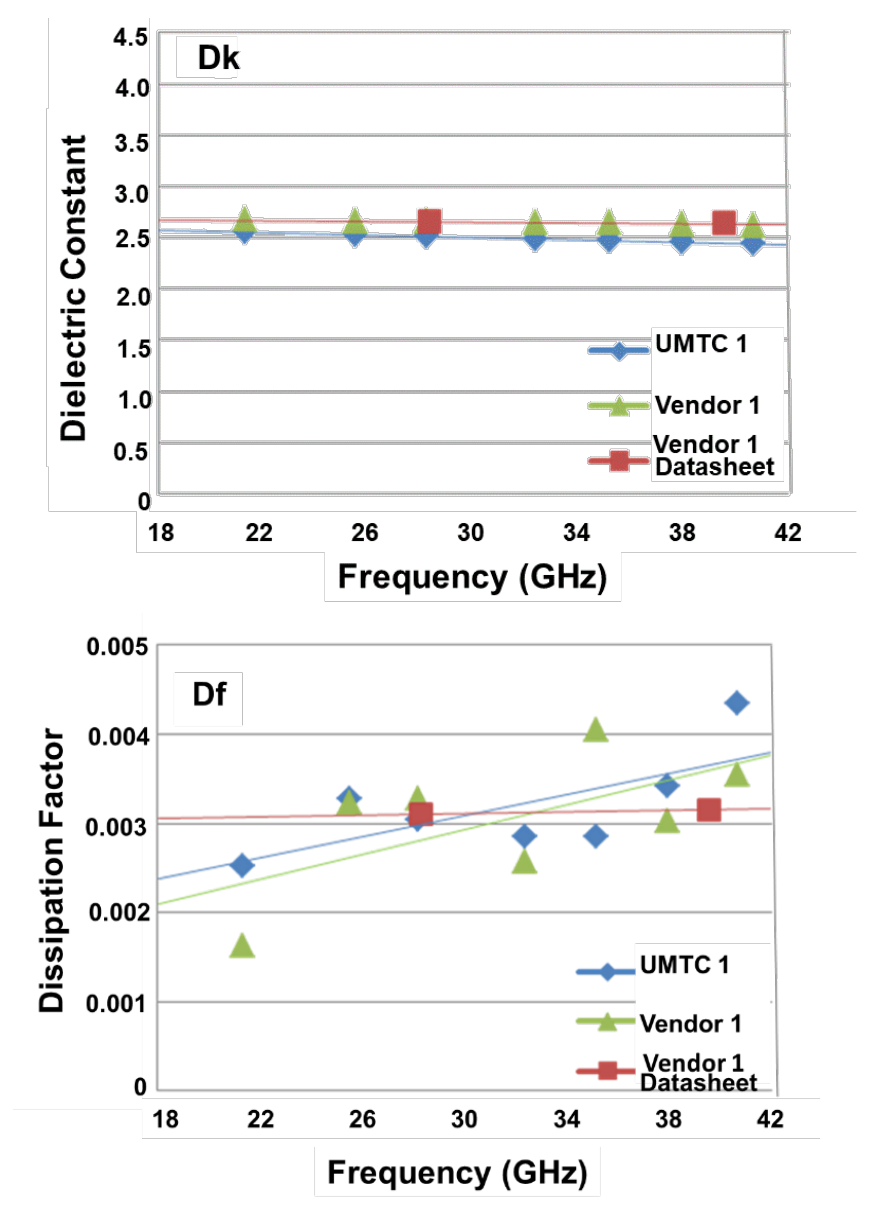
Figure 6. Dk and Df of Vendor 1.